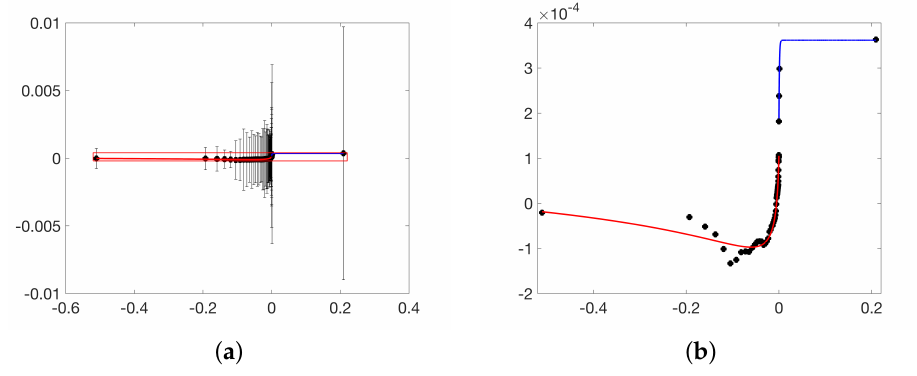
Figure 9. Same as Figure 8, but for the parameter ∂ρ